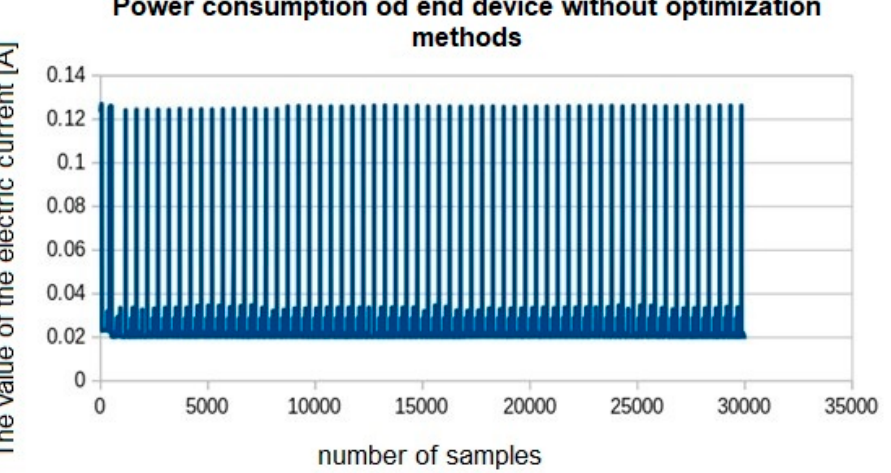
Figure 8. Graph of electricity consumption of the end device without the use of optimization meth- ods.